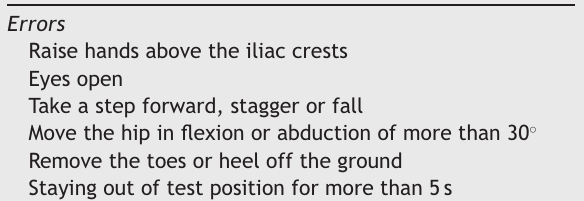
Balance Error Scoring System (BESS) scale scoring, which ascribes 1 point for each